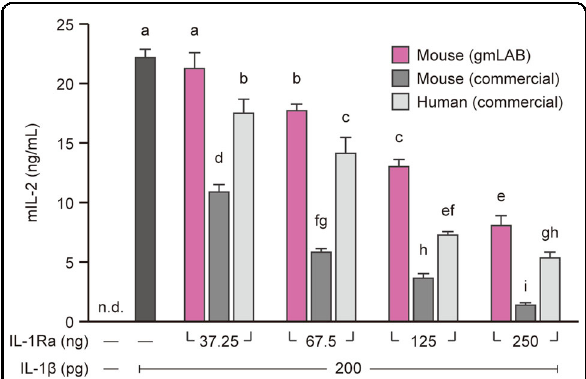
Fig. 3 Assay of the bioactivity of rmIL-1Ra puri fi ed from NZ-IL1Ra cellular extract. EL4.NOB-1 cells (2 × 10 5 ) were stimulated with IL-1 β (200pg/well) and various concentrations (37.25 – 250 ng/well)